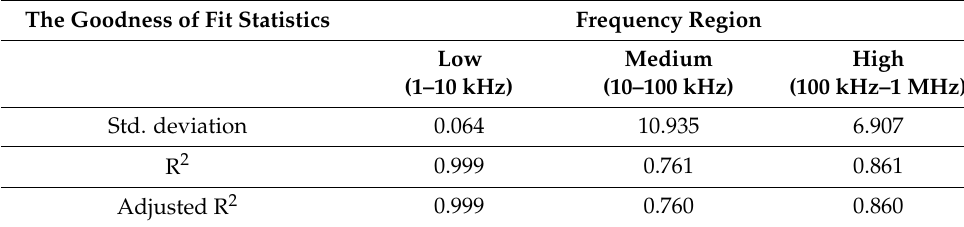
Table 14. Regression analysis for H2-H1 vs. H3-H2.